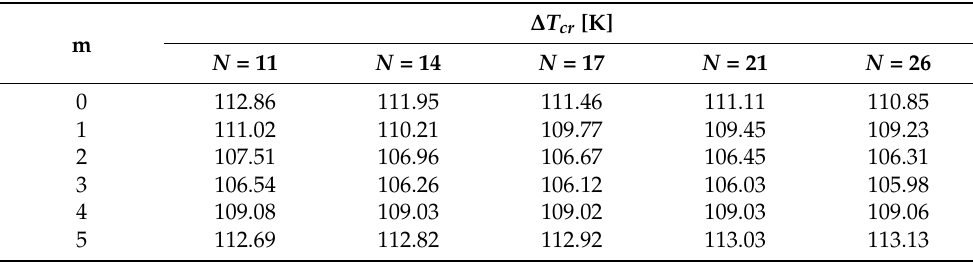
Table 1. Critical static temperature differences ∆ T cr of an FDM plate model loaded thermally with a positive gradient versus a different number N of discrete